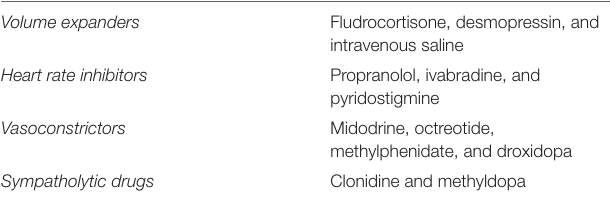
TABLE 2 | Therapeutic options in case of insufficient non-pharmacological measures or as a supplement in patients with serious refractory symptoms. Volume expanders